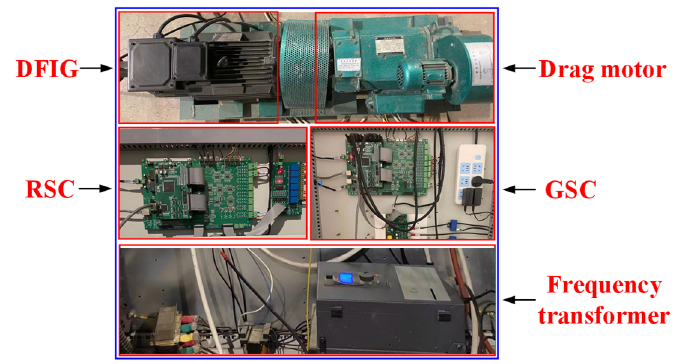
Figure 8. Hardware experiment platform.